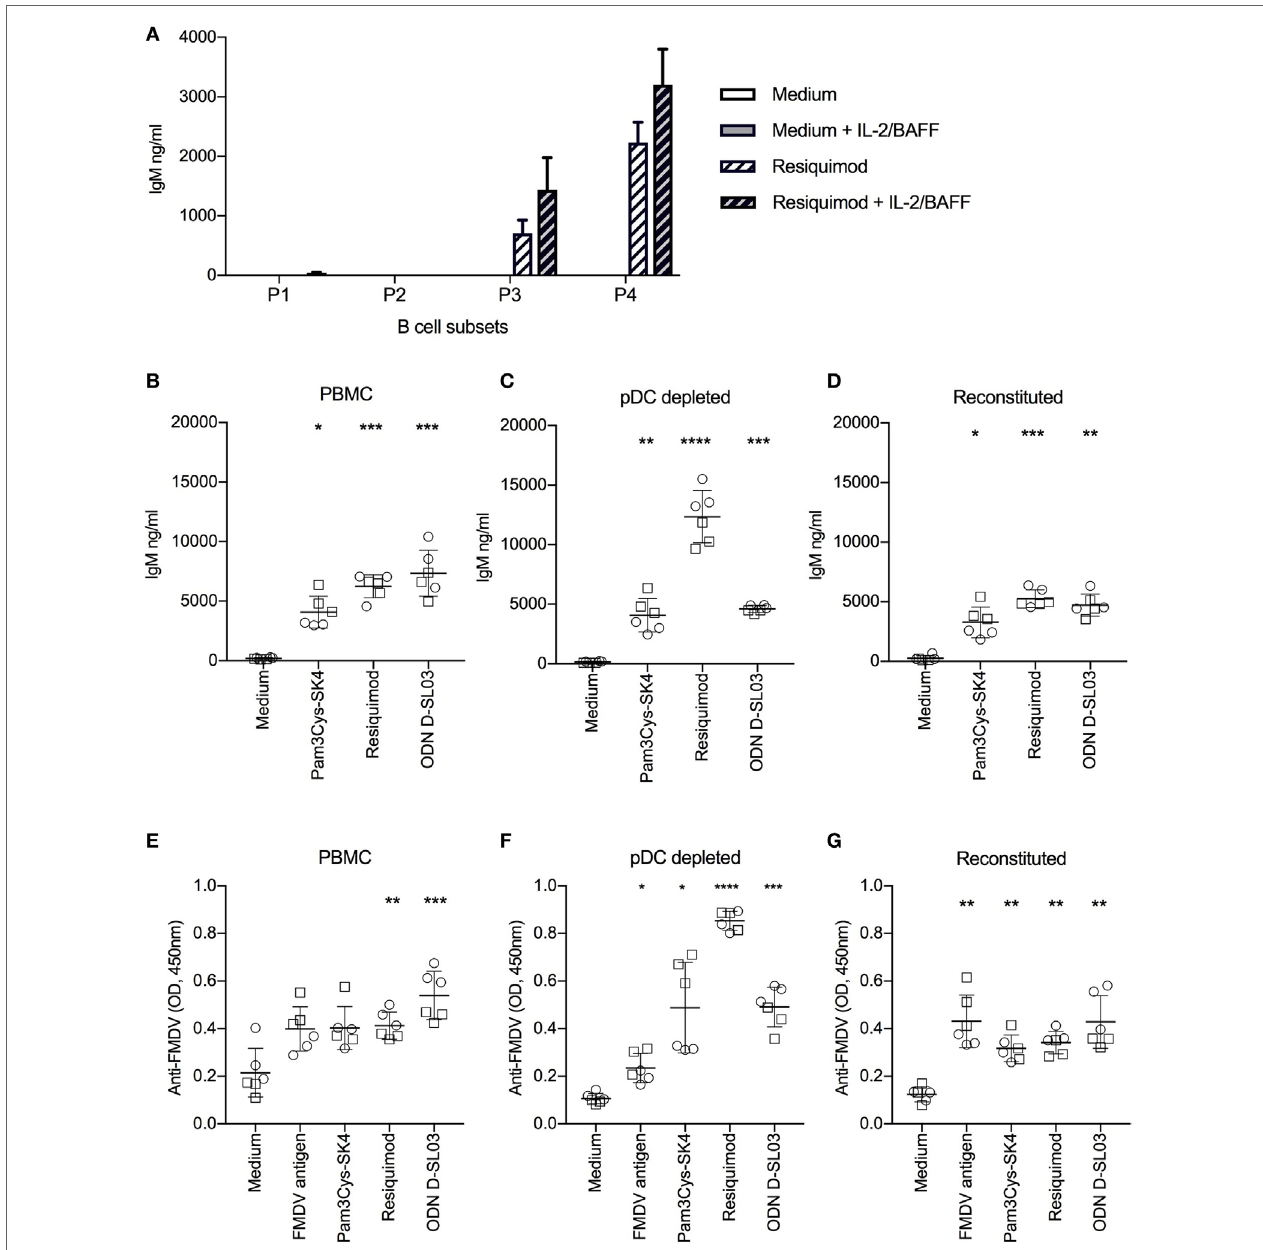
FigUre 5 | Antibody production after stimulation with toll-like receptor (TLR) ligands. (a) Spontaneous and induced IgM responses by B cell subsets. The B cell subsets P1–P4 defined as shown in Figure 2 were FACS-sorted, cultured at 0.5 × 10 6 cells/ml and stimulated with resiquimod in the absence or presence of interleukin-2 (IL-2) and B-cell activating factor (BAFF) for 5 days. IgM production in the supernatants was quantified by ELISA. (B) TLR-induced IgM production induced of full PBMCs, of plasmacytoid dendritic cell (pDC)-depleted PBMCs (c) , and of PBMCs reconstituted with pDC following sorting (D) . (e–g) FMDV-specific IgG-antibody levels detected in the same setup as in (B–D) . (B–g) Cells were cultured for 7 days. Six biological replicates of two independent experiments are shown. Statistical significance was calculated using ANOVA followed by Tukey’s test (**** P < 0.0001; *** P < 0.001; ** P < 0.01; * P <